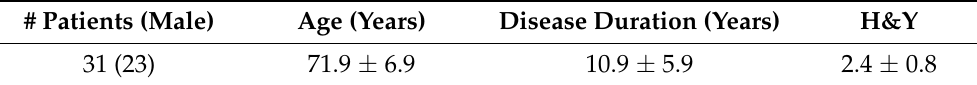
Table 1. Demographic and clinical features of patients enrolled in the present study (mean ± standard deviation). H&Y: Hoehn and Yahr.